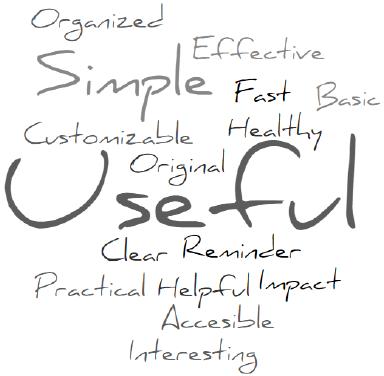
Figure 4. Word cloud of main characterizers used by evaluators.